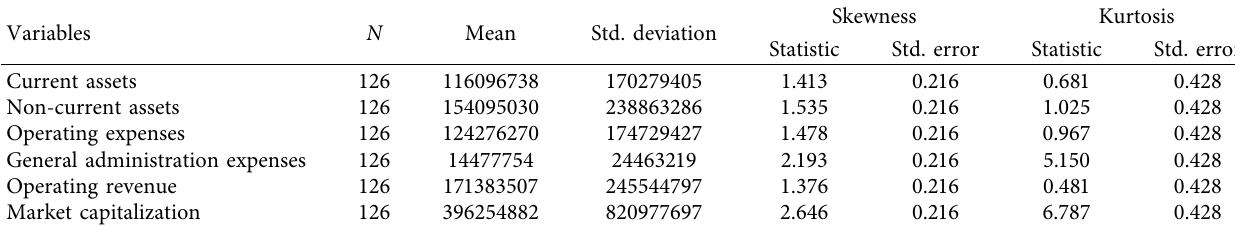
Table 5: Descriptive statistic for input and output variables.